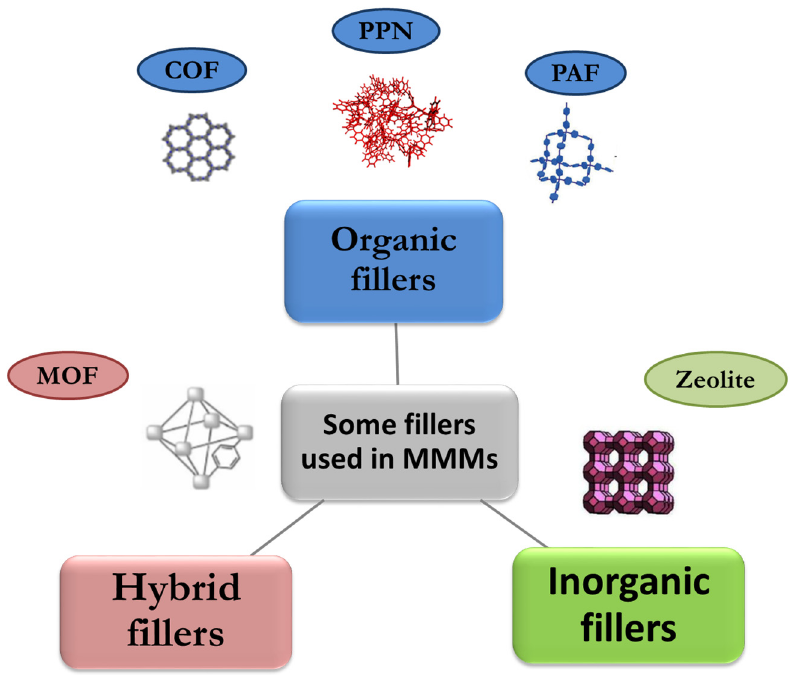
Figure 12. Some types of fillers used in MMM preparation (Adapted from Chakrabarty and co- workers, 2022) [129].